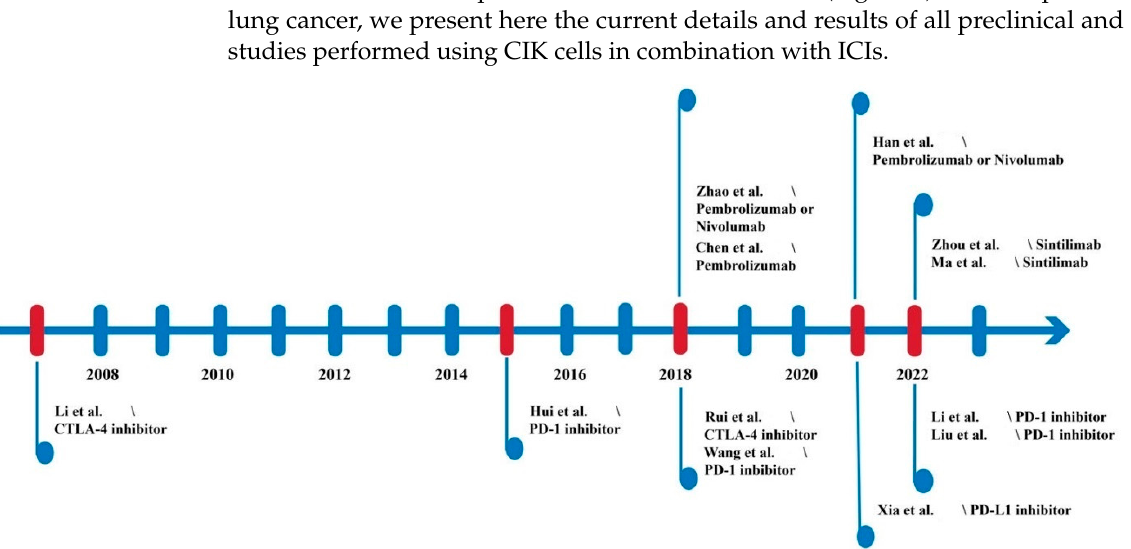
Figure 1. Timeline of CIK cell application with immune checkpoint inhibitors in the lung cancer context adapted from references [10–21].